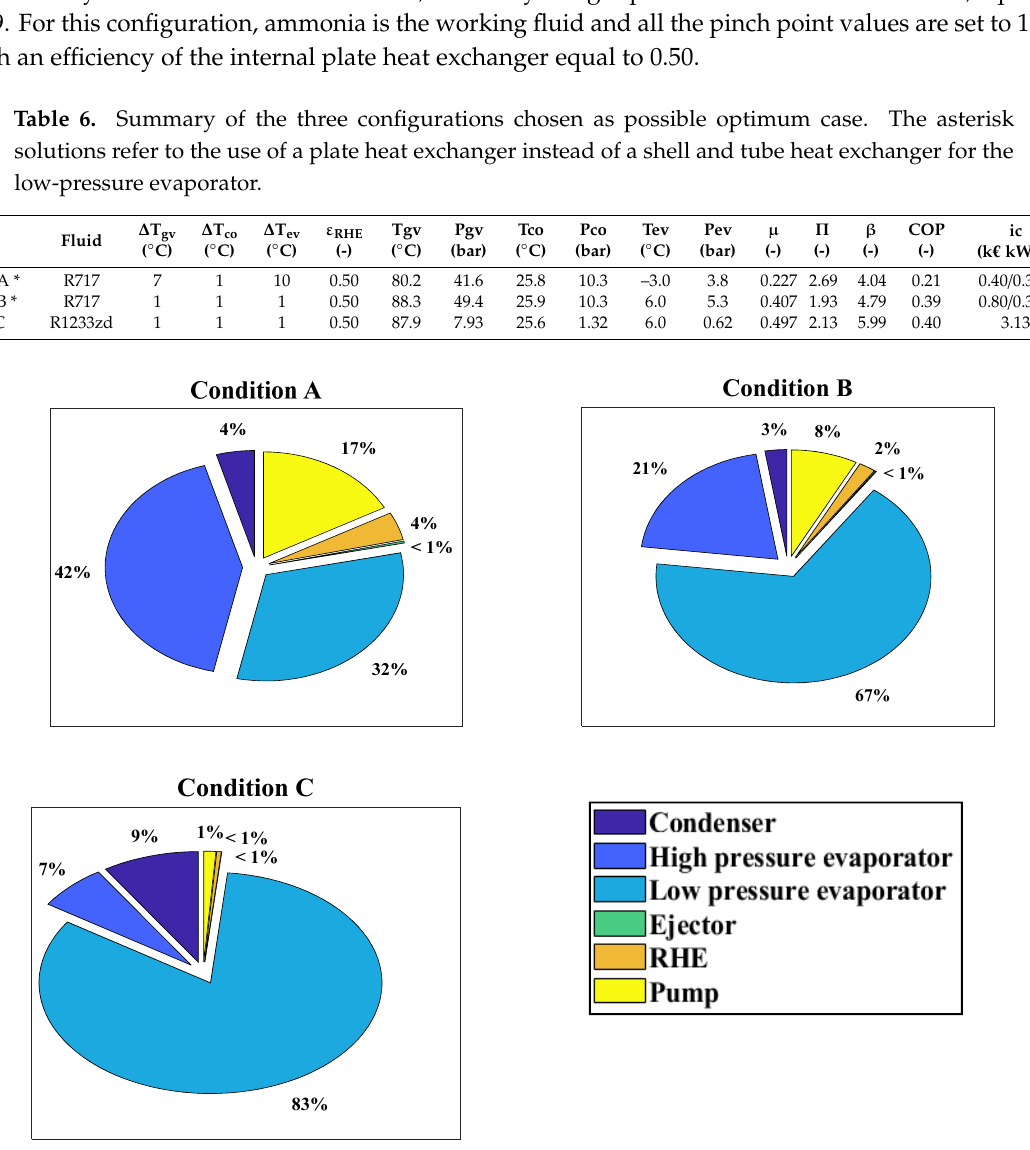
Figure 7. Share of the total investment costs for the hybrid ejector plant.